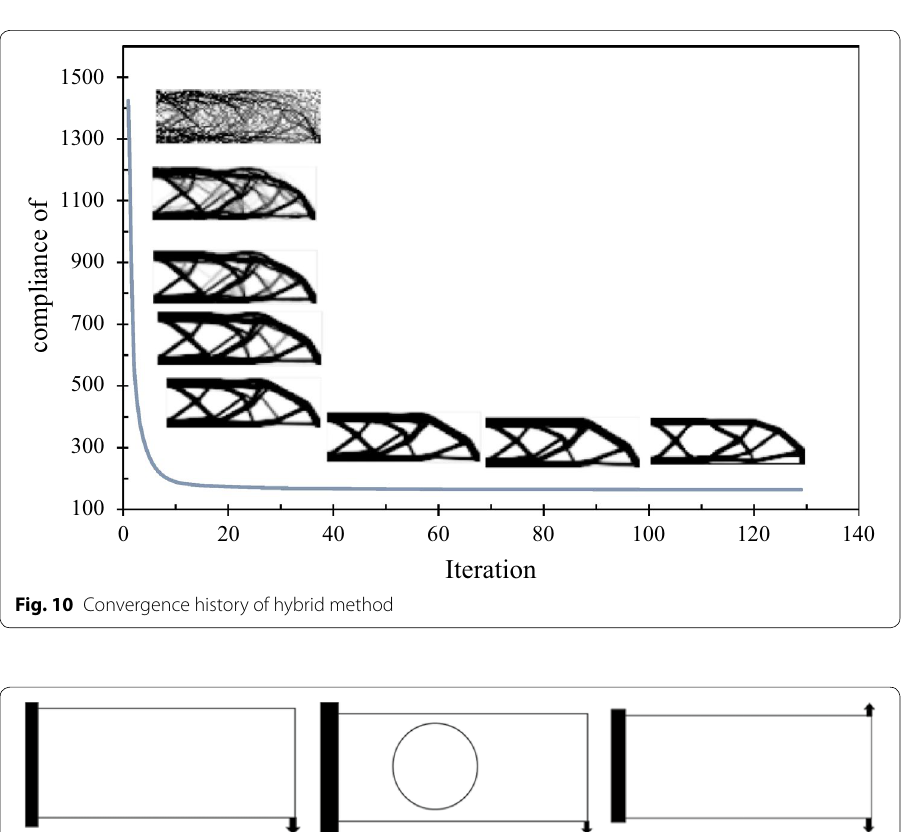
Fig. 11 Boundary and loading